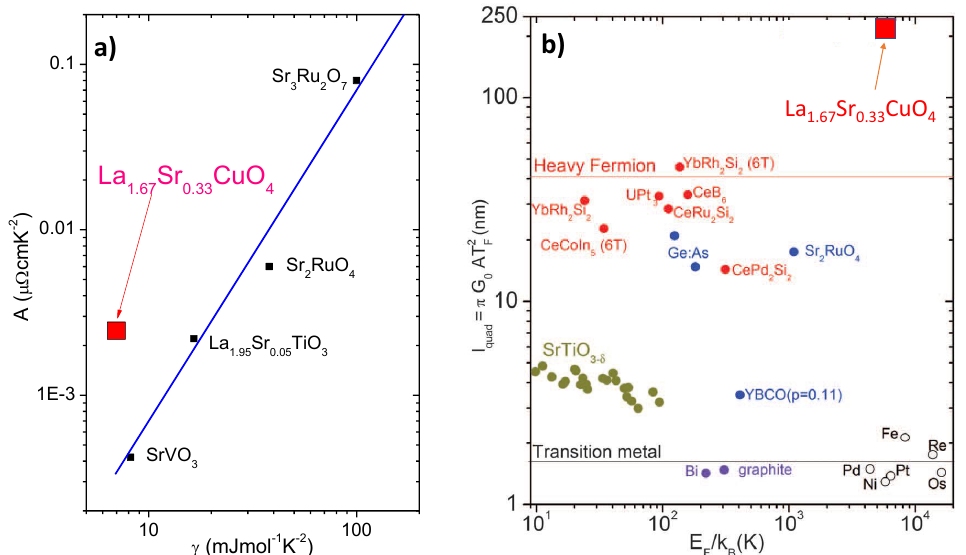
Figure 2: Standing out among Fermi liquids: a) The magnitude of the prefactor of T-square resistivity, A , vs. the Sommerfeld coefficient, γ , of several metallic per- [ 15 ] , Sr [ 16 ] , Sr ovskites. SrVO RuO Ru O (at zero magnetic field [ 17,18 ] ), and 3 2 4 3 2 7 [ 19 ] all follow Kadowaki-Woods scaling. In contrast, the magnitude La Sr TiO 1.95 0.05 3 [ 7, 8 ] is five times larger than what is expected given its γ . of A in La Sr CuO 1.67 0.33 4 b) (cid:96) , derived from the amplitude of A and fundamental constants (see text) in quad different Fermi liquids [ 20 ] . The large magnitude of (cid:96) in La Sr CuO stands quad 1.67 0.33 4